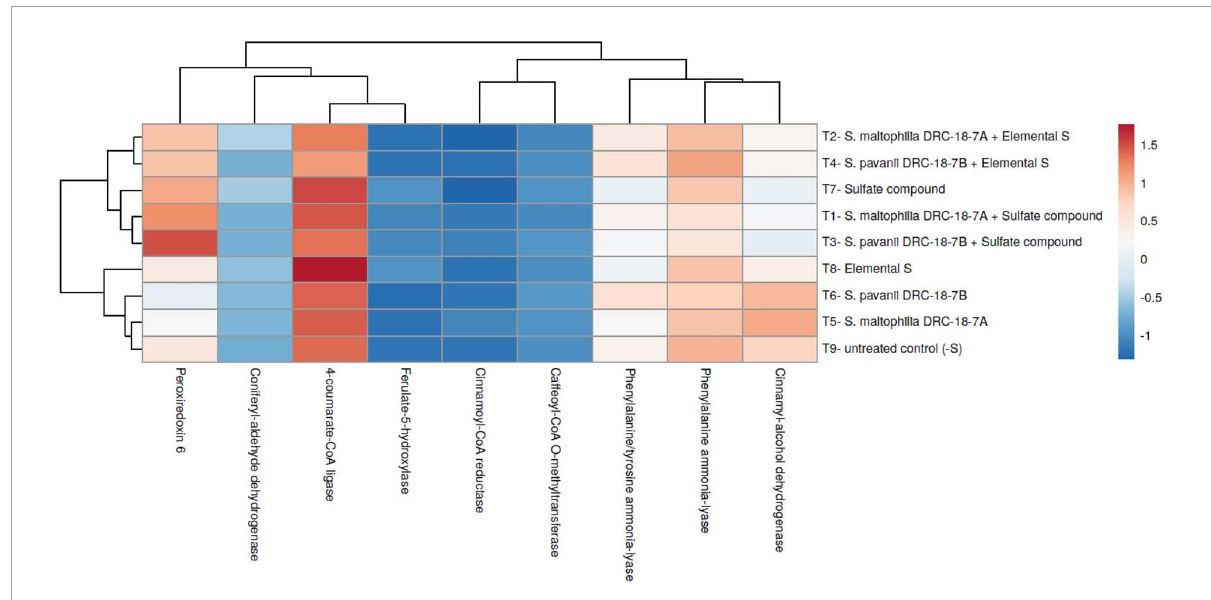
FIGURE9 Heatmap showing the effects of microbial inoculation on expression profile of key genes of phenylpropanoid pathways in leaves of pigeonpea at 30 days of sowing T 1 - Stenotrophomonas maltophilia DRC-18-7A + Sulfate compound, T 2 - S. maltophilia DRC-18-7A + Elemental S, T 3 - S. pavanii DRC-18-7B + Sulfate compound, T 4 - S. pavanii DRC-18-7B + Elemental S, T 5 - S. maltophilia DRC-18-7A, T 6 - S. pavanii DRC-18-7B, T 7 - Sulfate compound, T 8 - Elemental S and T 9 - untreated control (-S).